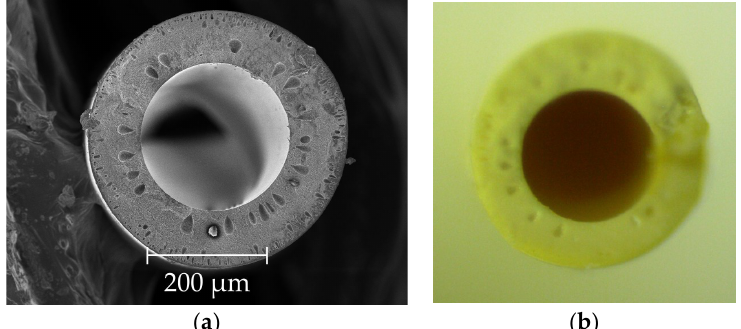
Figure 3. ( a ) SEM micrograph of the hollow fiber cross-section; ( b ) optical micrograph of the hollow fiber cross-section.